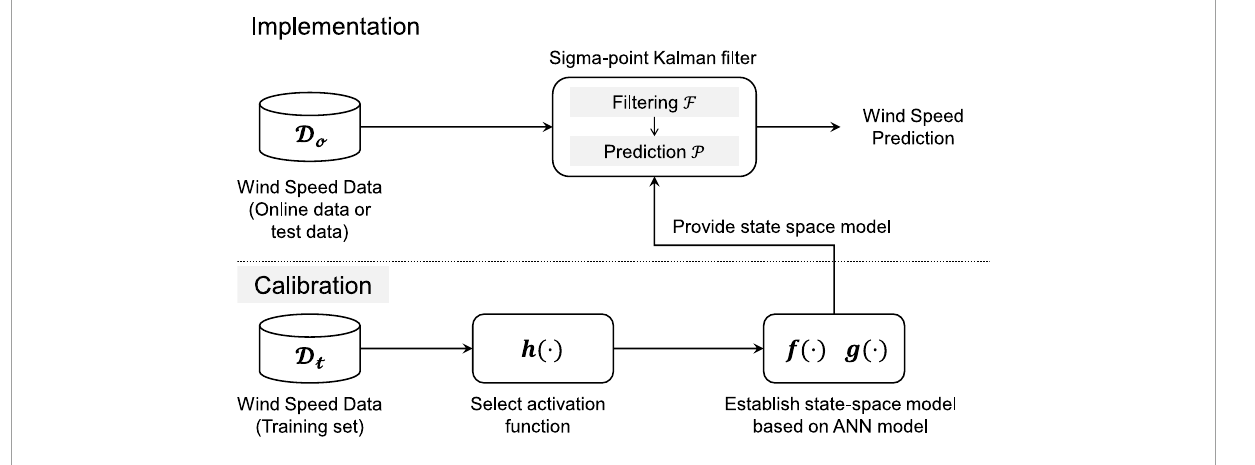
FIGURE 2 Framework of the ELKF method for predicting wind speed.